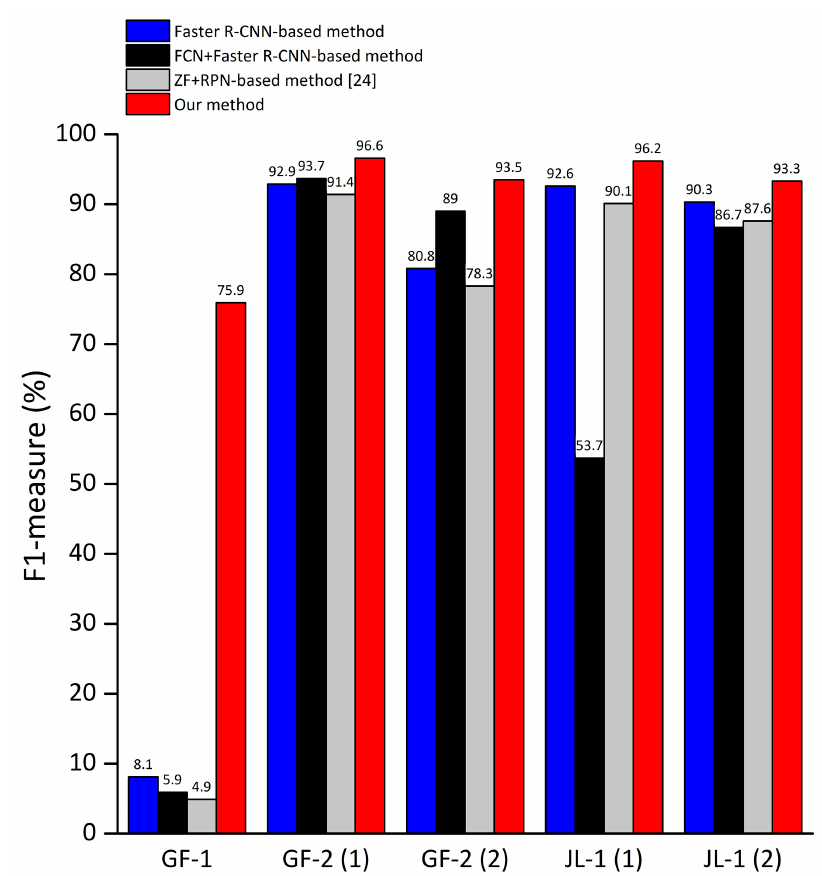
Figure 13. The F1-measure of the proposed method compared with other methods for deep learning-based ship detection.